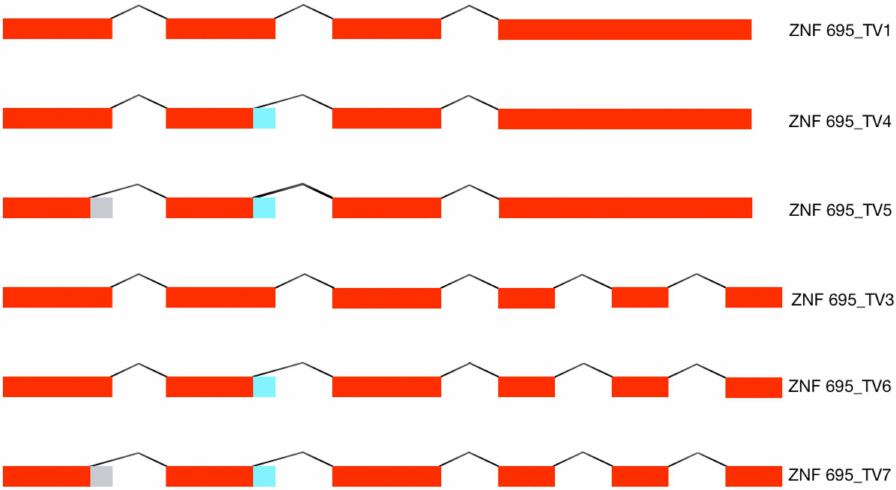
Figure 4. AS model of the ZNF695 transcript variants. The figure shows the six alternative transcripts expressed in the four cell lines. The red boxes indicate the coding sequences (exons), the gray boxes indicate the alternative splice site 1 (SS1), and the blue boxes indicate the alternative splice site 2 (SS2) identified in the cancer cell